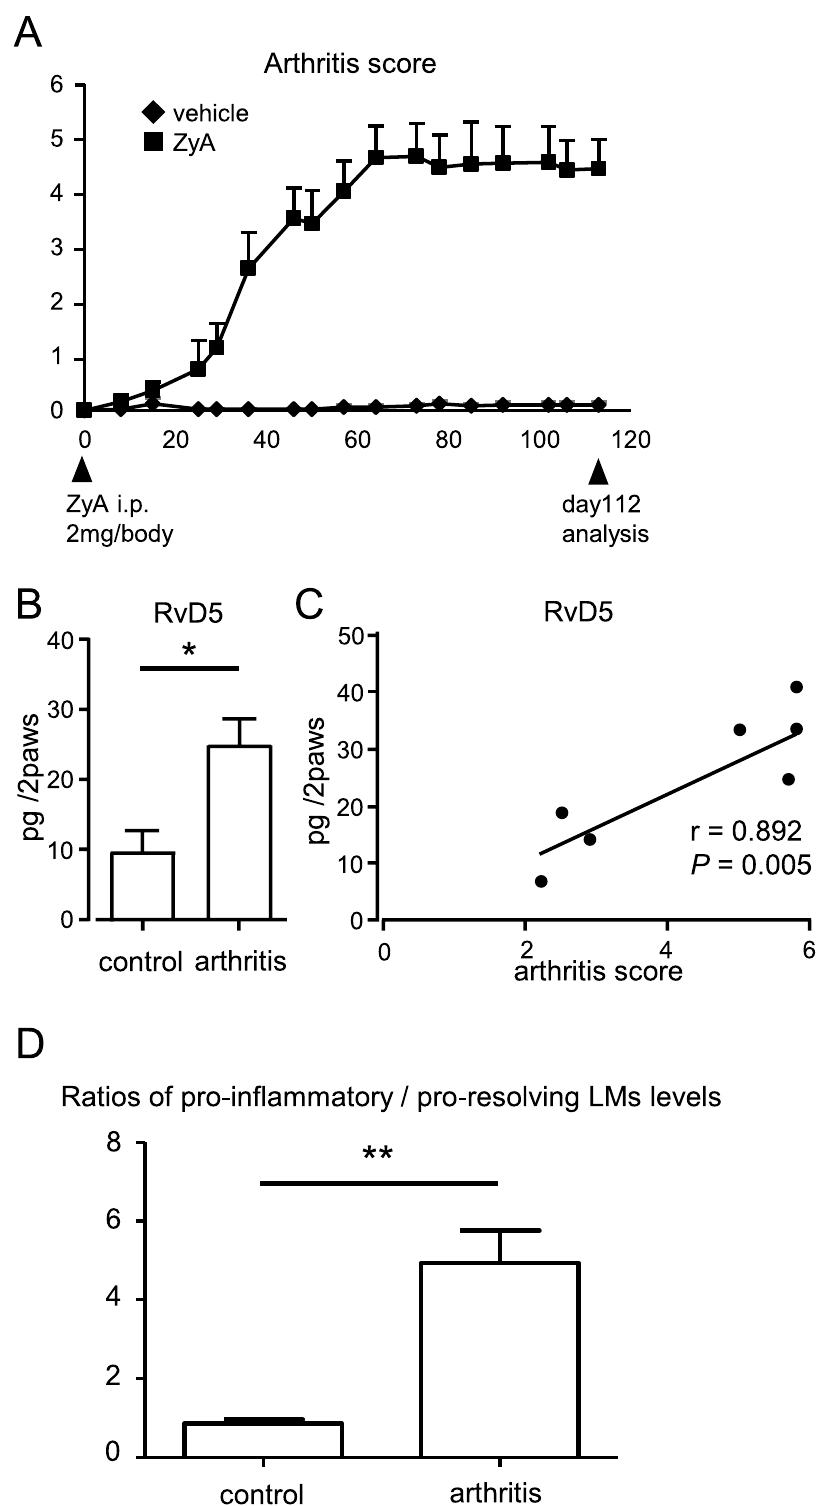
Figure 1. RvD5 is elevated in arthritis and correlates with the degree of arthritis. ( A ) SKG mice were injected with ZyA (2 mg/body i.p.) on day 0. On day 112, paws were removed and analyzed. ( B ) LM quantified using LC/ MS/MS-based LM profiling (control group, n = 5, arthritis group, n = 8). Bars represent mean ± SEM. * P < 0.05, by Mann–Whitney U test and FDR-BH correction. ( C ) Correlation between disease activity and RvD5 level (Spearman’s rank correlation coefficient). ( D ) Ratios of pro-inflammatory versus pro-resolving lipid mediator levels. Bars represent mean ± SEM. ** P < 0.01, by Mann–Whitney U